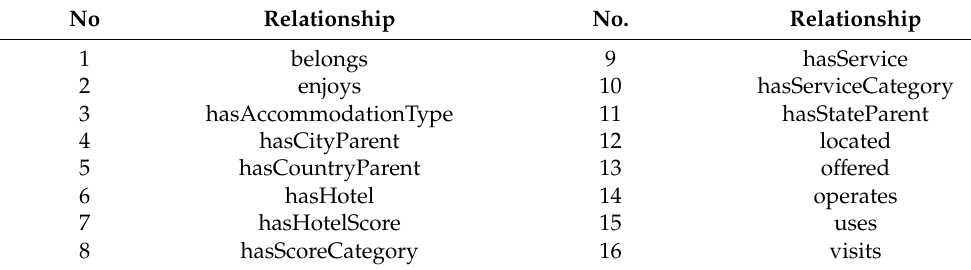
Table 4. OntoTouTra relationships (owl:topObjectProperty). No Relationship